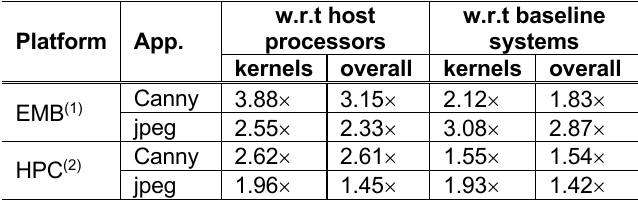
Table 1. Speed-ups comparison between our